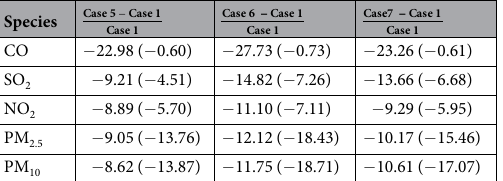
Table 3. Predicted percentage reductions and amounts * (in parentheses) corresponding to Cases 5, 6, and 7 relative to Case 1 in January in Beijing. * Units of CO are mg m − 3 and those of other species are µ g m − 3 .